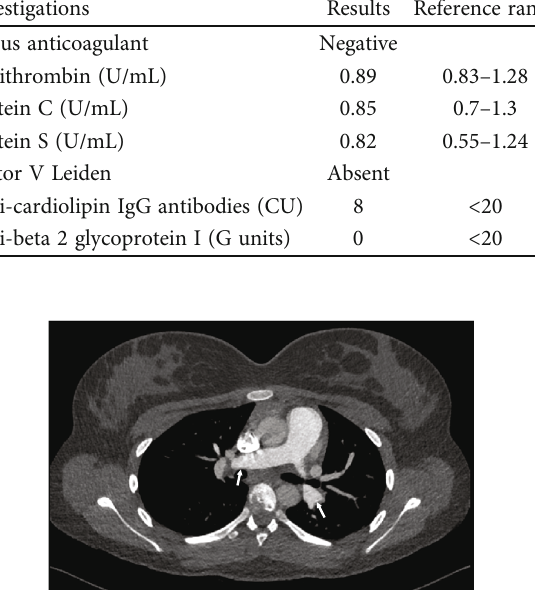
Figure 3: CTPA performed six months post thrombolysis with resolution of pulmonary embolism